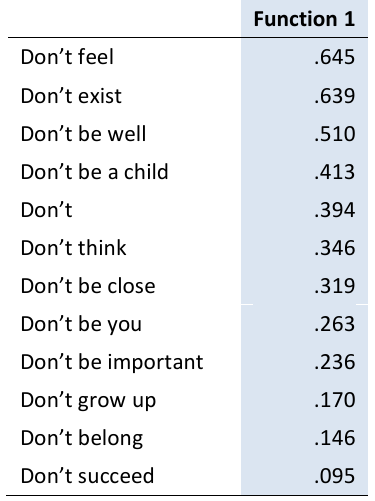
Table 7: Matrix of the isolated discriminant function structure